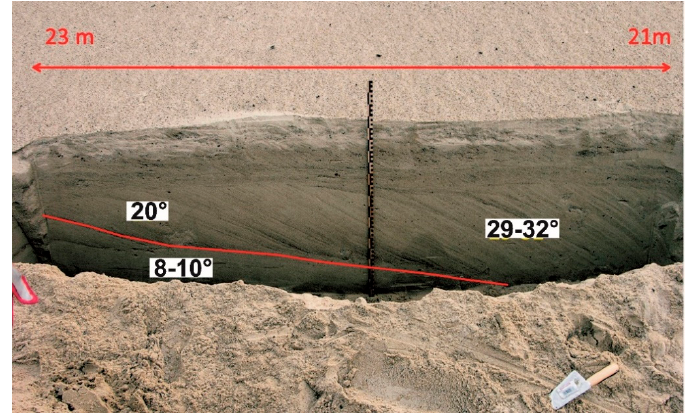
Figure 9. Sedimentary structures in the first pit.